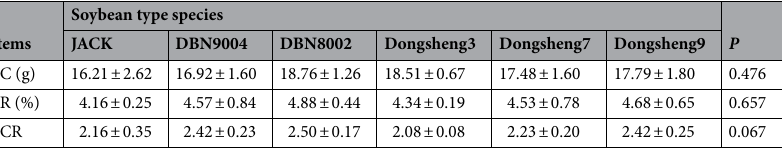
Table 5. The effects on the feeding of channel catfish fed transgenic soybeans (n = 25). FC, Feed conversion; FR, feeding rate; FCR, feed conversion ratio. p < 0.05 indicates significant differences among the six experimental groups.